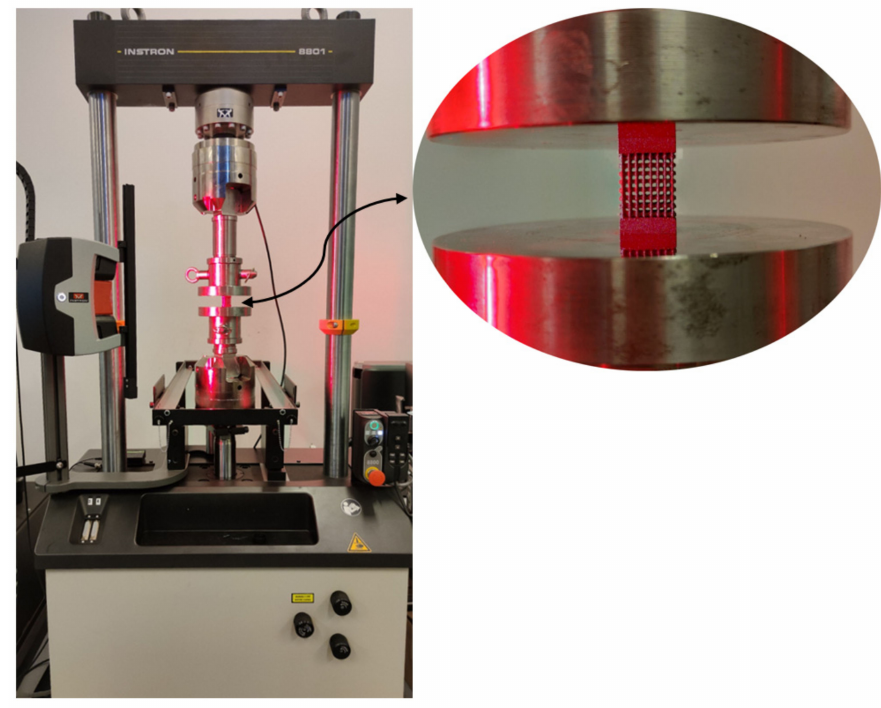
Figure 3. Testing setup.